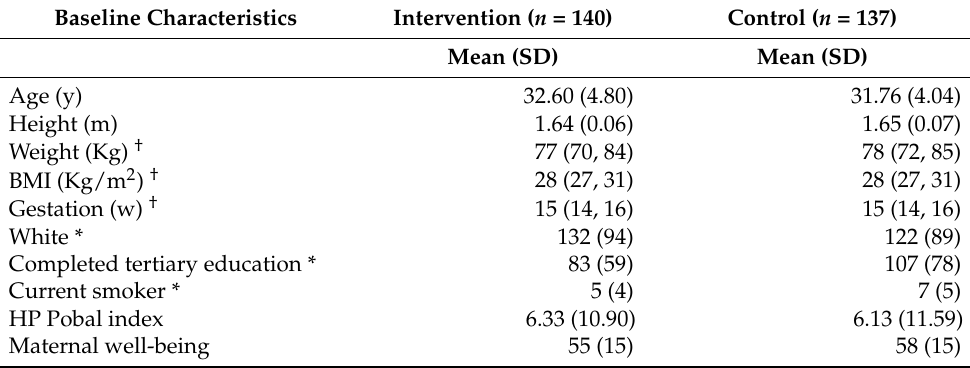
Table 1. Baseline characteristics of the study population ( n = 277).